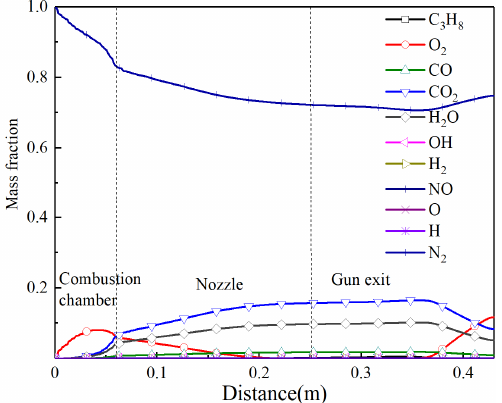
Figure 4. The mass fraction of different gas components along the centerline.